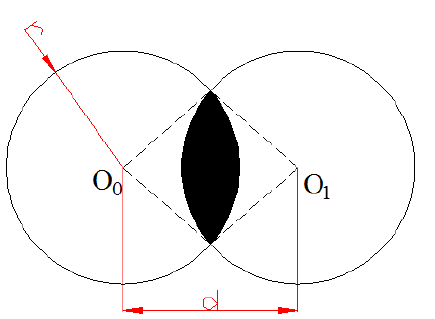
Figure 8. The painting model.